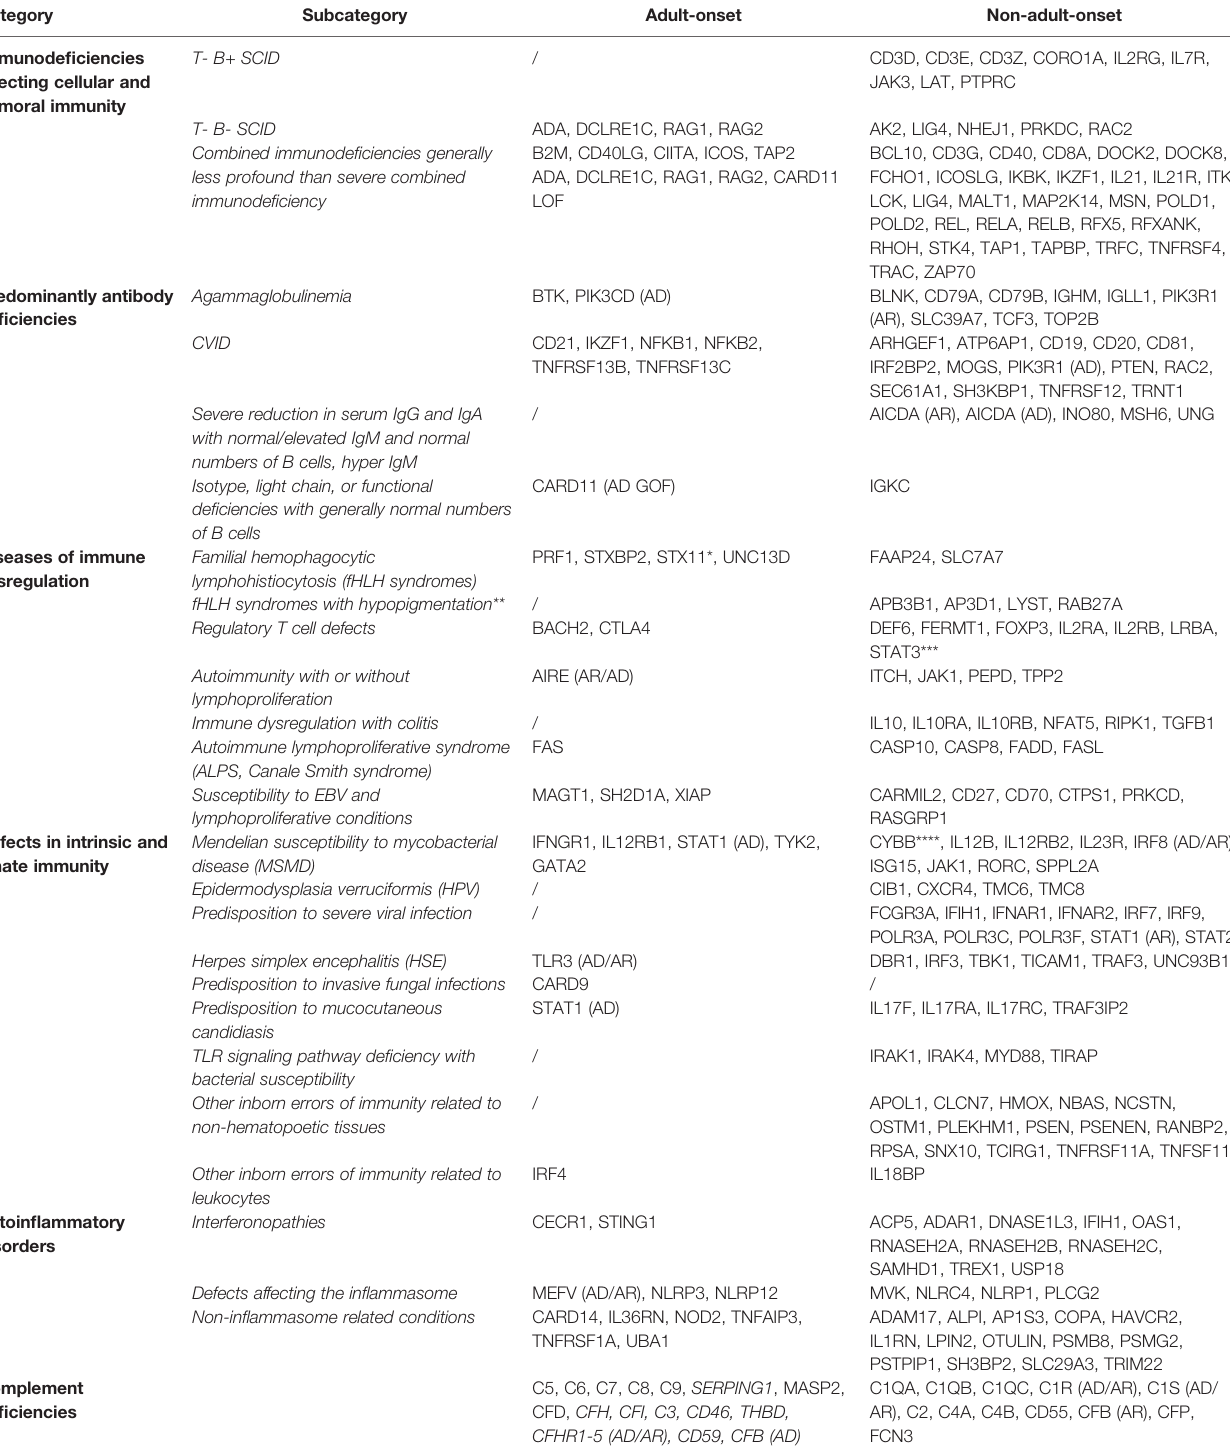
TABLE 1 | Adult vs non-adult-onset associated genes implicated in